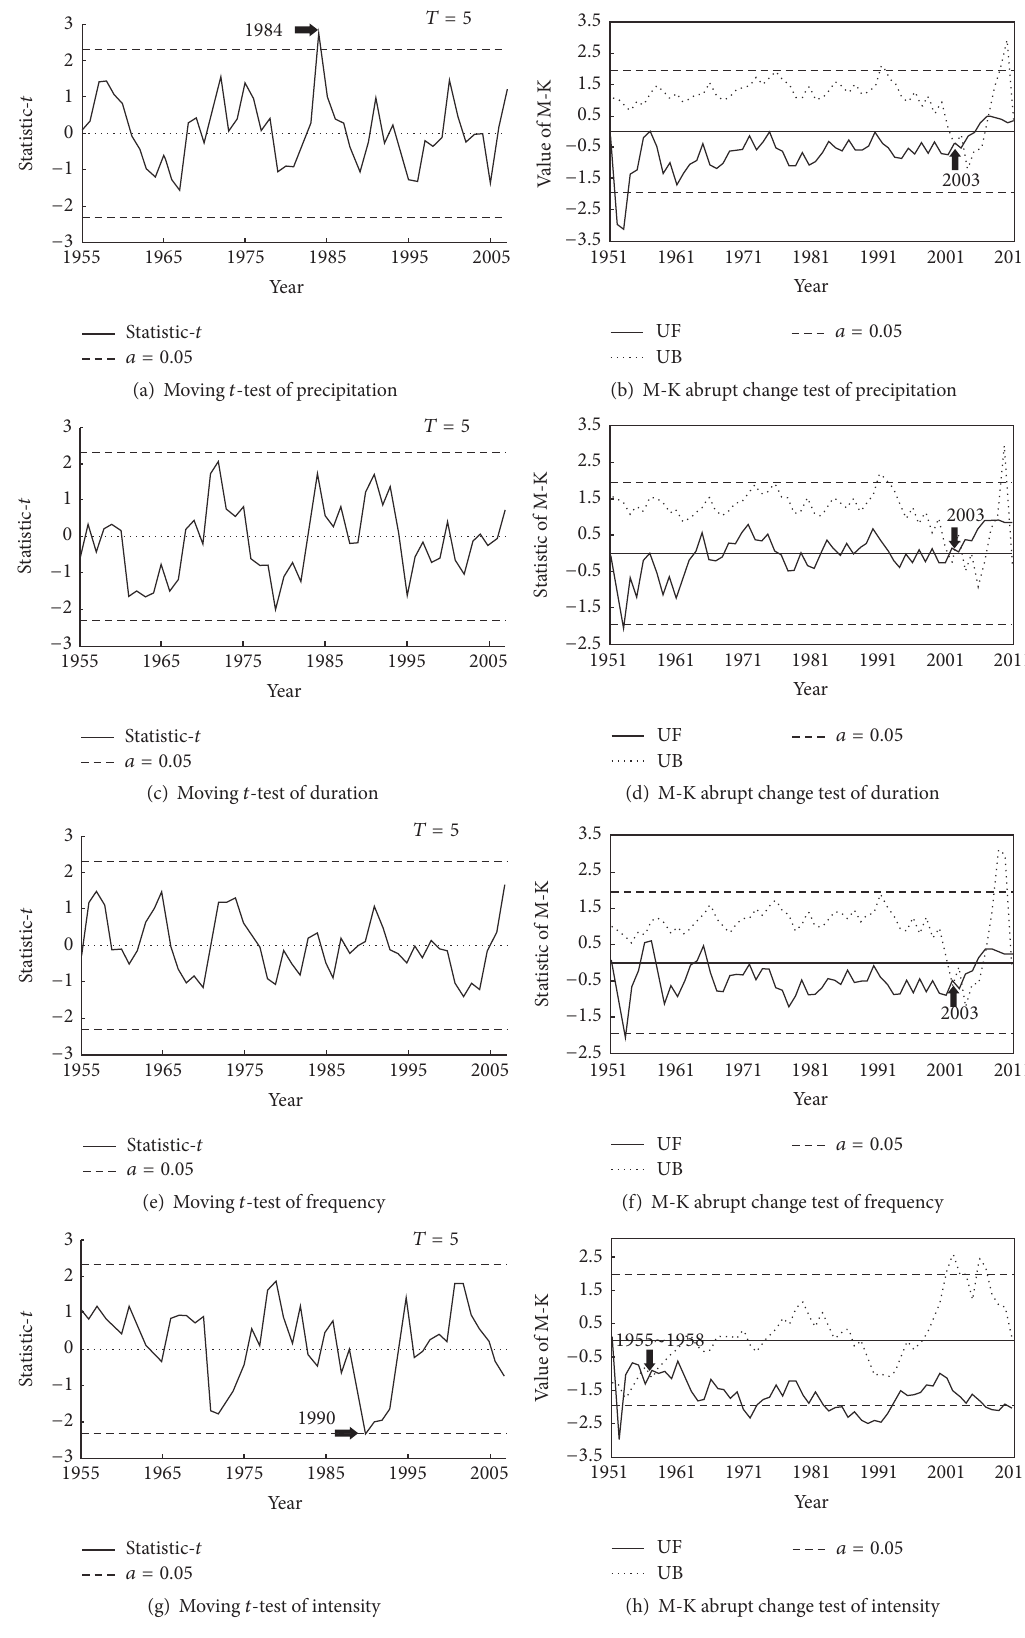
Figure 11: Mutations from Mann-Kendall test and moving 𝑡